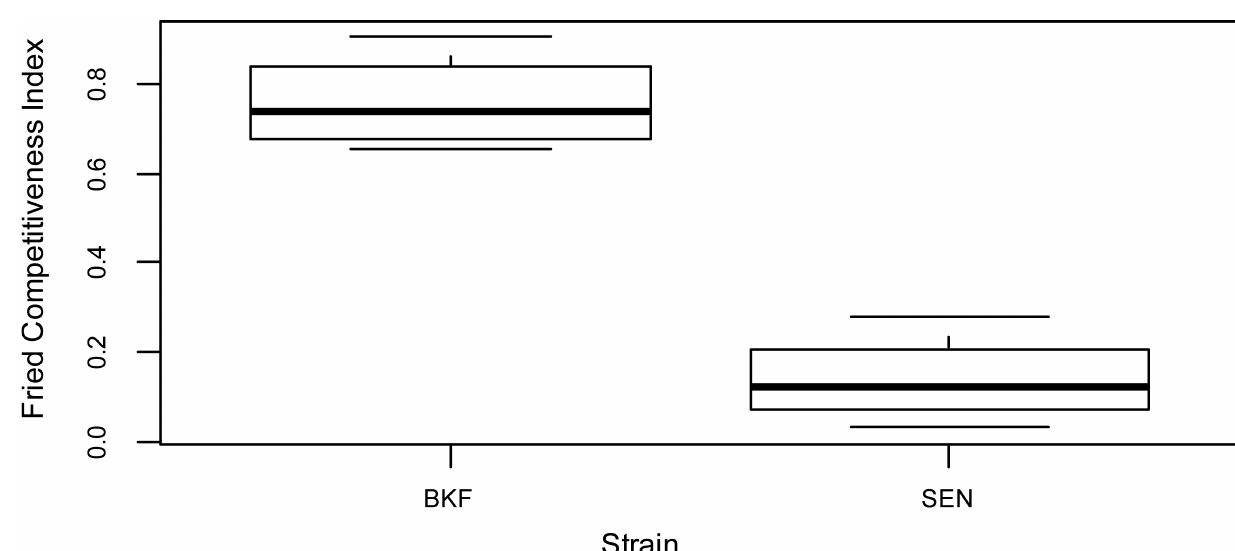
Fig 2. AverageFried index per month of two strains of Glossina palpalis gambiensis in Senegal. Sterile BKF and SEN males were releasedin the Parc de Hann of Dakar from June to September 2011 and 2015